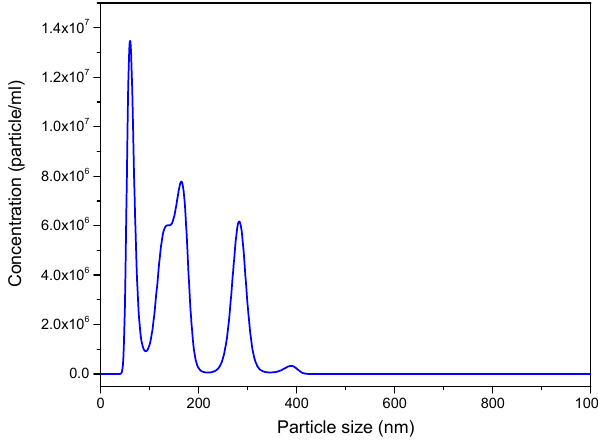
Figure 6. Nanoparticle tracking analysis (NTA) size distribution curve of GNS.